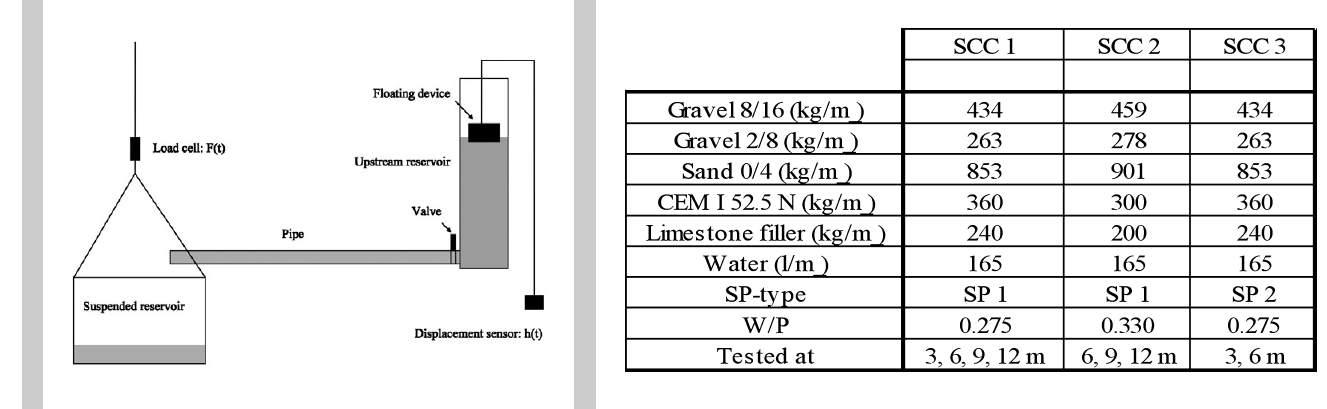
Figure 4: Schematic overview of the test setup. Table 1: Concrete composition of SCC type 1, type 2 and type 3. Remark that the amount of superplasticizer can be adjusted in order to increase or decrease the